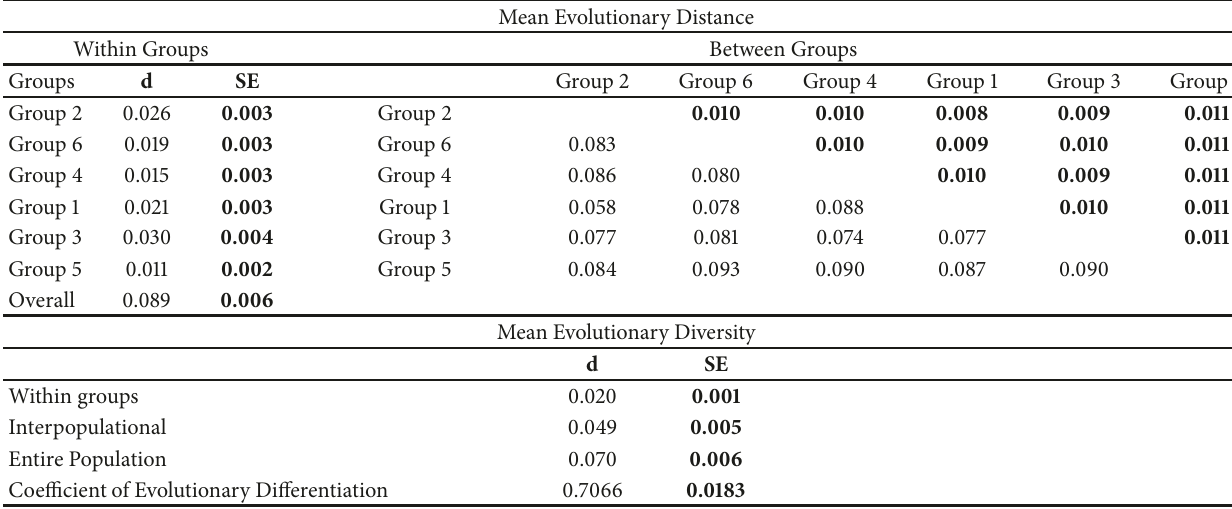
Table 4: Estimates of the average evolutionary divergence over sequence pairs of the CP genes of CTV isolates from different citrus growing regions of the world belonging to previously established strain